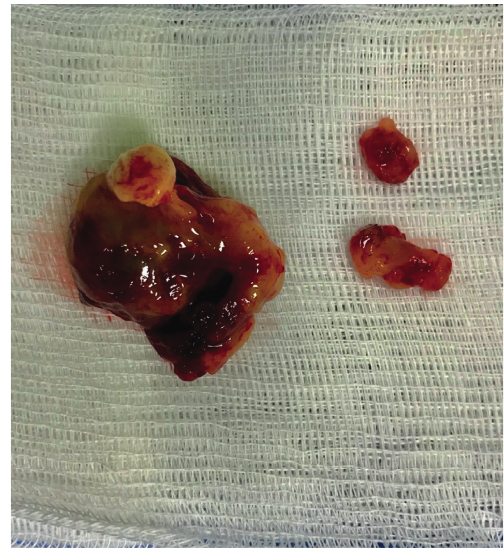
Figure 4: Gross image of the mass revealed multiple fragments of soft tan-gray tissue.